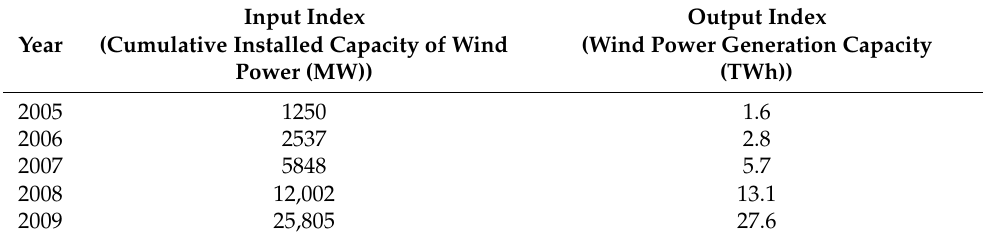
Table 3. Input–output indexes of wind power development